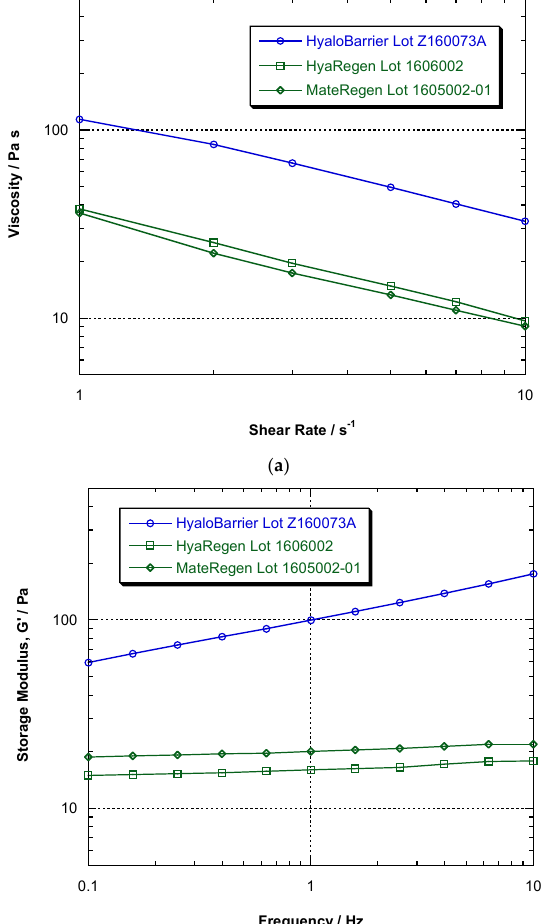
Graphs are plotted on a logarithmic scale, as there are large variations in viscosity over a wide range of shear rates. Figure 4. Comparison of physical characteristics of hyaluronic acid gels. ( a ) Comparison of viscosity vs. shear rate flow curves for gel A (Hyalobarrier ® ) and gels B and C (HyaRegen ® and MateRegen ® ). ( b ) Comparison of storage moduli G’ versus frequency for hyaluronic acid-based products.